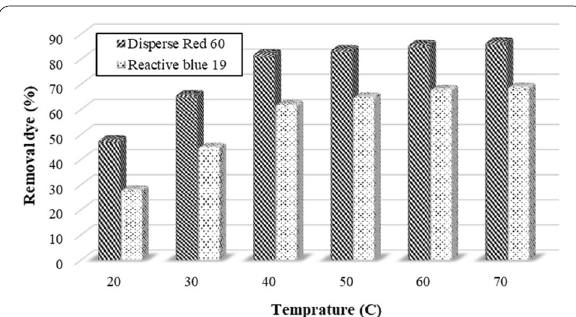
Fig. 6 Effect of slow-mixing time on removal efficiency of Disperse red 60 and Reactive blue 19 dyes. (Initial pH 11, Alcea rosea = concentration 200 mg/L and initial dye concentration 40 mg/L = = for Disperse experiments; initial pH 11, concentration 250 mg/L = = and initial dye concentration 20 mg/L for Reactive experiments) =